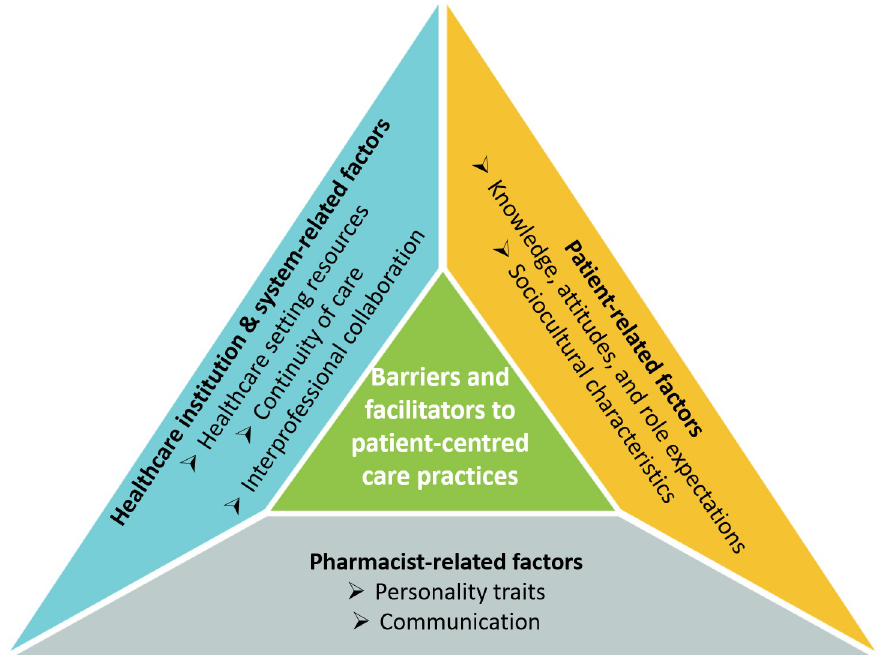
Fig 1. Barriers and facilitators to patient-centred care